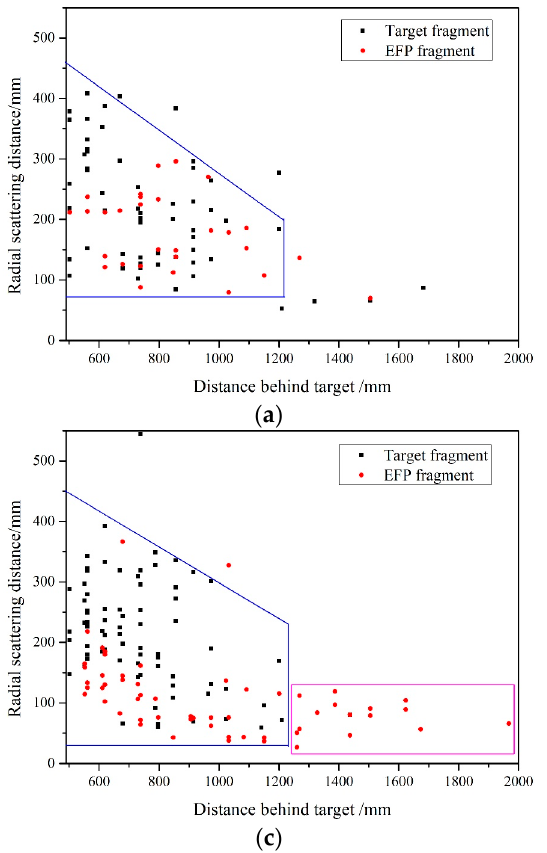
Figure 9. Relationship between the radial scattering distance and the distance behind the target. ( a ) L / D = 1.66 ( b ) L / D = 2.4 ( c ) L / D = 3.86.